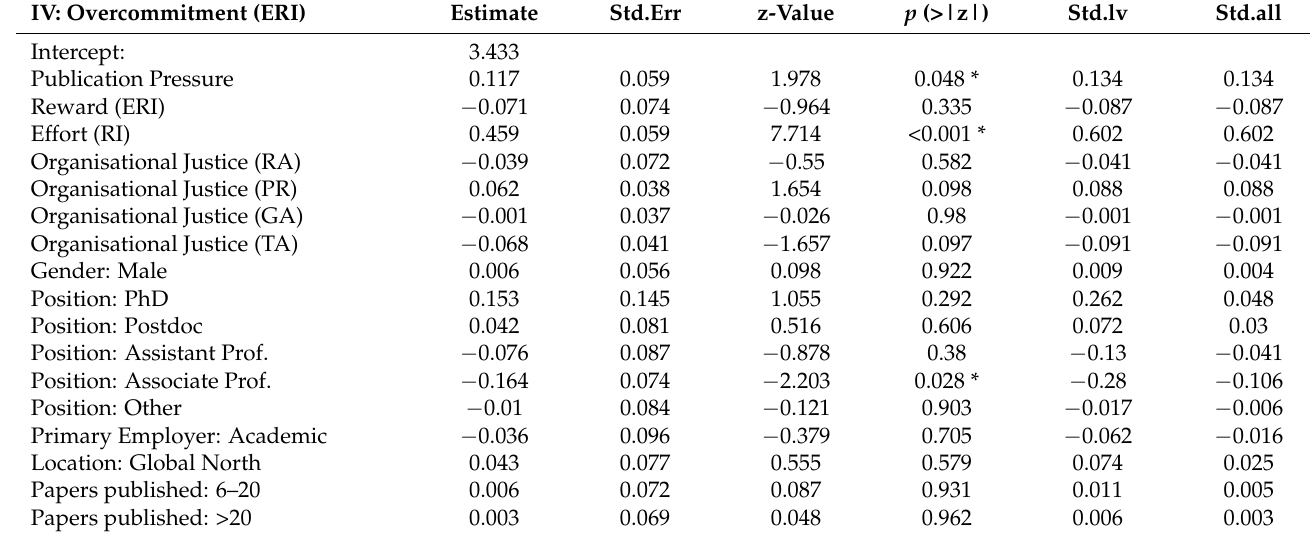
Table 6. Extracted output for the independent variable “Overcommitment” from the regression analysis of our SEM model. * indicates statistical significance ( p <